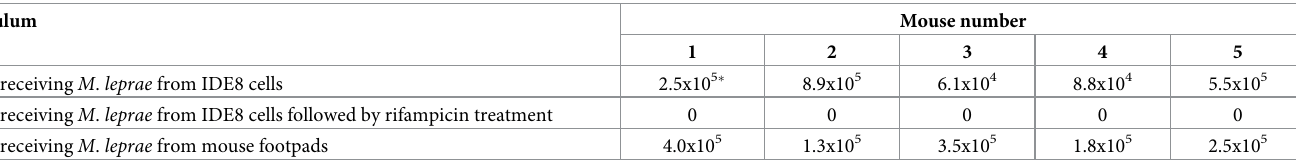
treatment with rifampicin (negative control group), or inoculation with 10 4 bacteria freshly harvested from mouse footpads (positive control